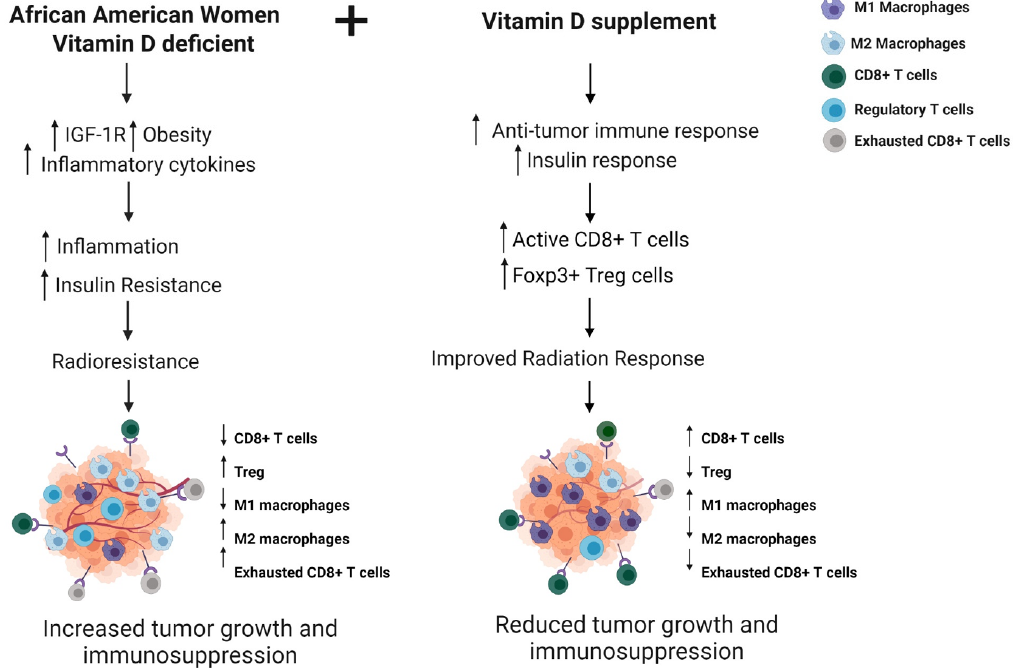
Figure 1. Vitamin D supplementation to modulate antitumor immune response and radiation sensitivity in African American breast cancer patients. Vitamin D deficiency is prevalent in African American women and is associated with upregulation of the IGF-1R signaling pathway with resulting immunosuppression and increase in inflammatory cytokine levels leading to tumor growth and radiation resistance. Modeling supplementation with vitamin D, radiation response would improve by increasing antitumor immune response. Created with BioRender.com Breast cancer patients who are obese or have metabolic syndrome have an increased risk of breast cancer, worse cancer outcomes, and radiation resistance [61]. According to the CDC, the prevalence of obesity among adults in the United States is 42.5%, with 9.2% being severely obese [62]. It has been found that metabolic syndrome leads to a 47% in- crease in relative risk of breast cancer [63], which spans across all breast cancer subtypes [64,65]. Mechanistically, patients who are obese or have metabolic syndrome commonly have insulin resistance and an adipokine imbalance, which results in systemic inflammation that is known to be associated with disease progression and work outcomes. The insulin resistance results in increased production of IGF-1, resulting in upregu- lation of the IGF-1R/AKT pathway, promoting carcinogenesis, angiogenesis, migration, and invasion. IGF-1R also inhibits apoptosis [66,67]. The adipokine imbalance is notable for a decrease in levels of adiponectin, with in- creased leptin levels. This combination negatively regulates inflammation and cell prolif- eration, leading to increased breast cancer risk [68,69], cell proliferation, migration, and invasion [70]. Unfortunately, the adipokine imbalance plays a role in proinflammatory pathways, resulting in the release of TNF- α , IL-1, IL-6, and IL-12 and reactive oxygen spe- cies (ROS) [68]. Systemic inflammation due to obesity/metabolic syndrome results in li- polysis, which releases free fatty acids (FFAs). FFAs stimulate TLR4 present on breast can- cer cells, activating NF-kB, which increases cancer stem cells. The inflammatory cytokines, including IL-8, IL-6, CCL2, CCL5, and IP-10 produced from adipocytes, promote cancer stem cell expansion.